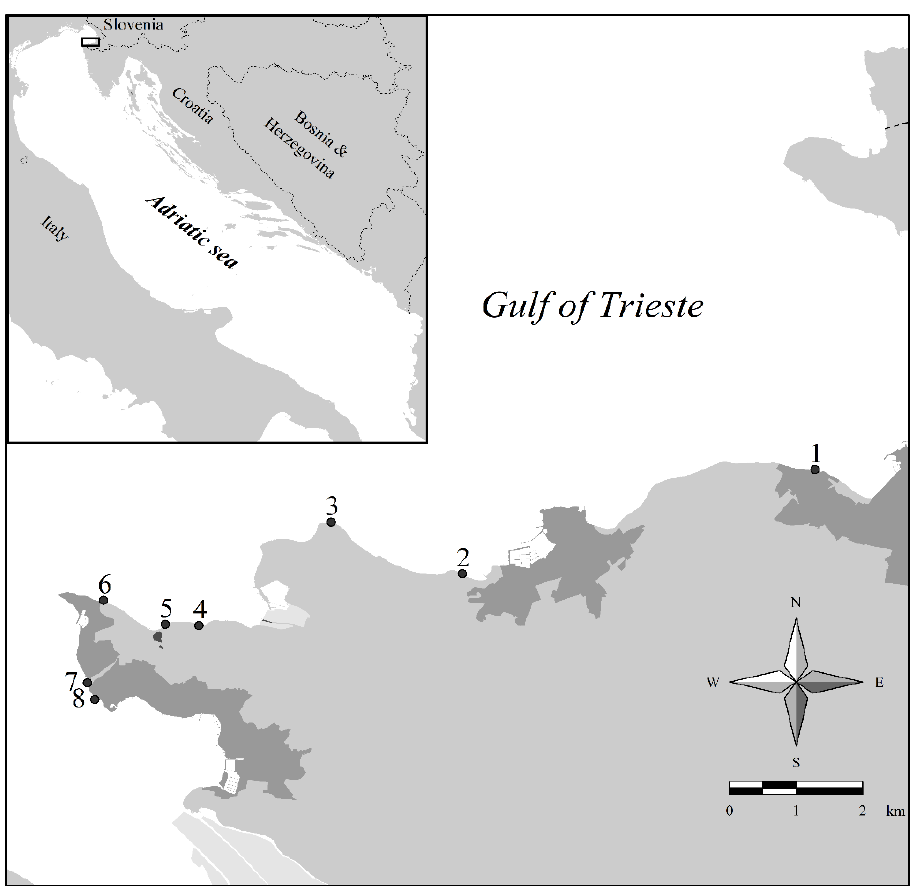
Figure 1. Map of the study area with 8 sampling sites for Serranus scriba (for the names of the sites see Table 1).